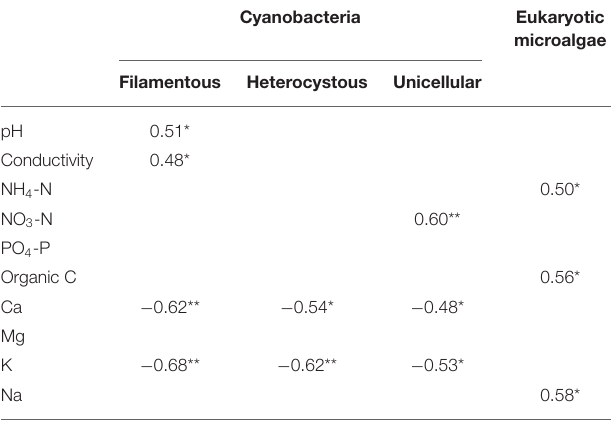
TABLE 4 | Eukaryotic microalgae isolated from the three localities. Microalgal Site isolate